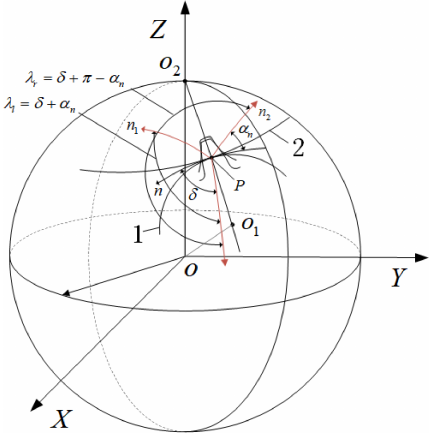
Figure 2. The intersection Angle between the normal arcs of tooth profile. 1 – Bevel gear cutter pitch circle of noncircular bevel gear. 2 – Noncircular bevel gear pitch curve of noncircular bevel gear.